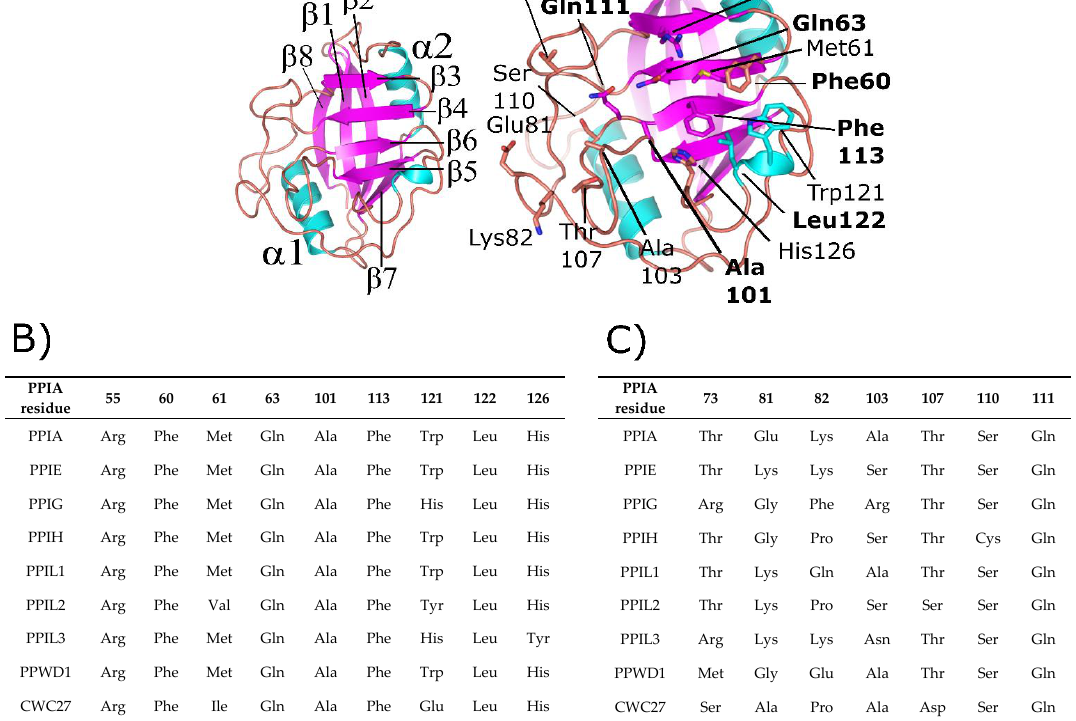
Figure 1. Structure and annotation of the canonical cyclophilin PPIA. ( A ) Left panel, secondary structural elements are labeled for the PDB ID: 2CPL. Right panel, residues that comprise the S1 (proline-binding) and S2 (specificity) pockets are shown in stick representation and labeled. S1 pocket labels are on the right, S2 pocket labels on the left, and in bold are residues invariant across the nuclear cyclophilin family. Residue numbering also follows PPIA, by convention. ( B ) The residues that comprise the S1 pockets are largely invariant, while ( C ) the residues that comprise the S2 pockets are more variable.